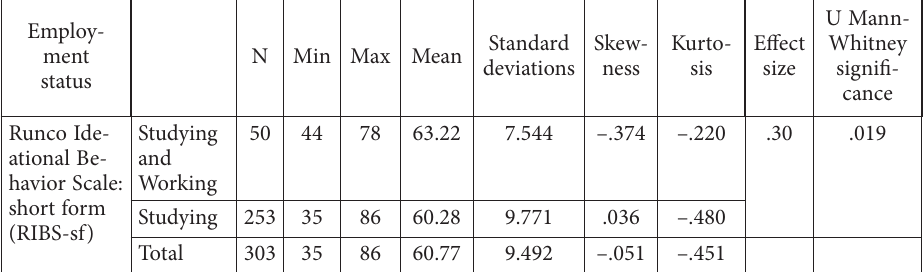
Table 6. Frequencies for the constructs of divergent thinking based on living at home or away from home and the results of the Mann–Whitney U test (source: created by authors)